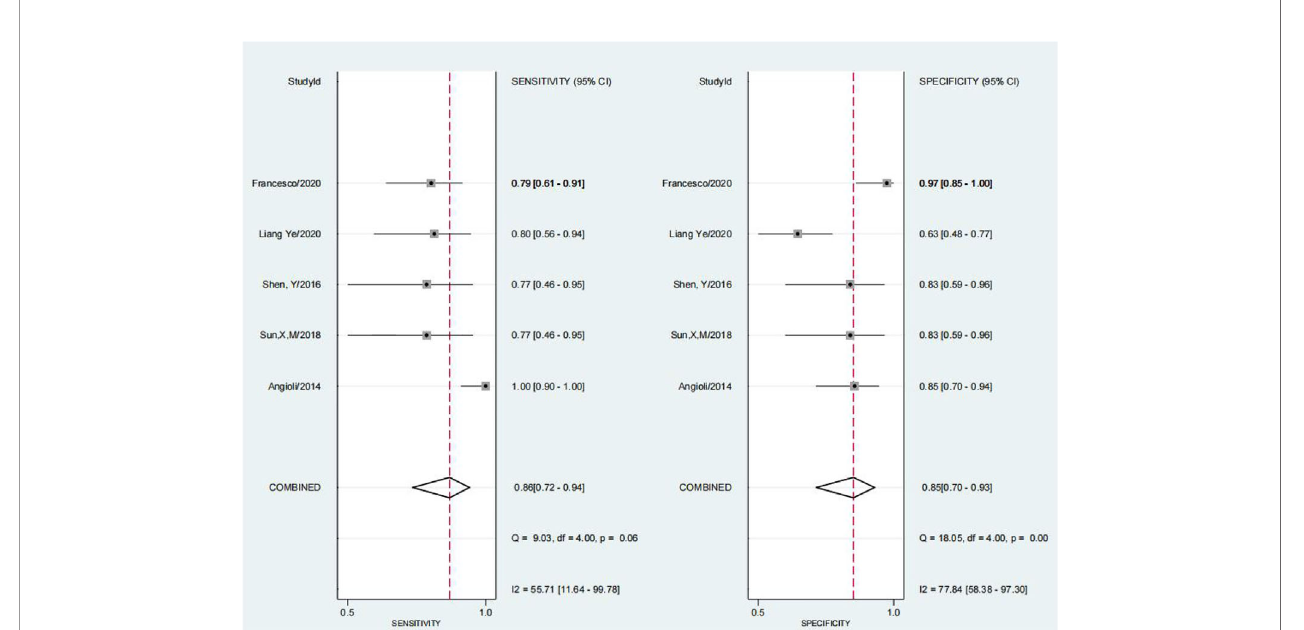
FIGURE 6 | Forest Plots of paired sensitivity and speci fi city for preoperative serum HE4.